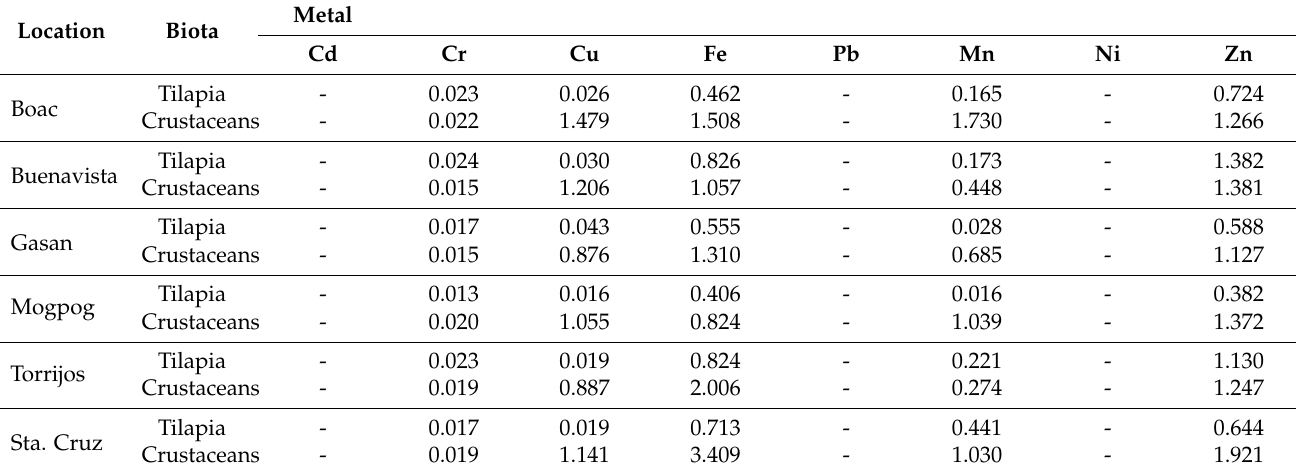
Table 6. The estimated daily intake (EDI) of metals (mg kg − 1 day − 1 ) through crustaceans and